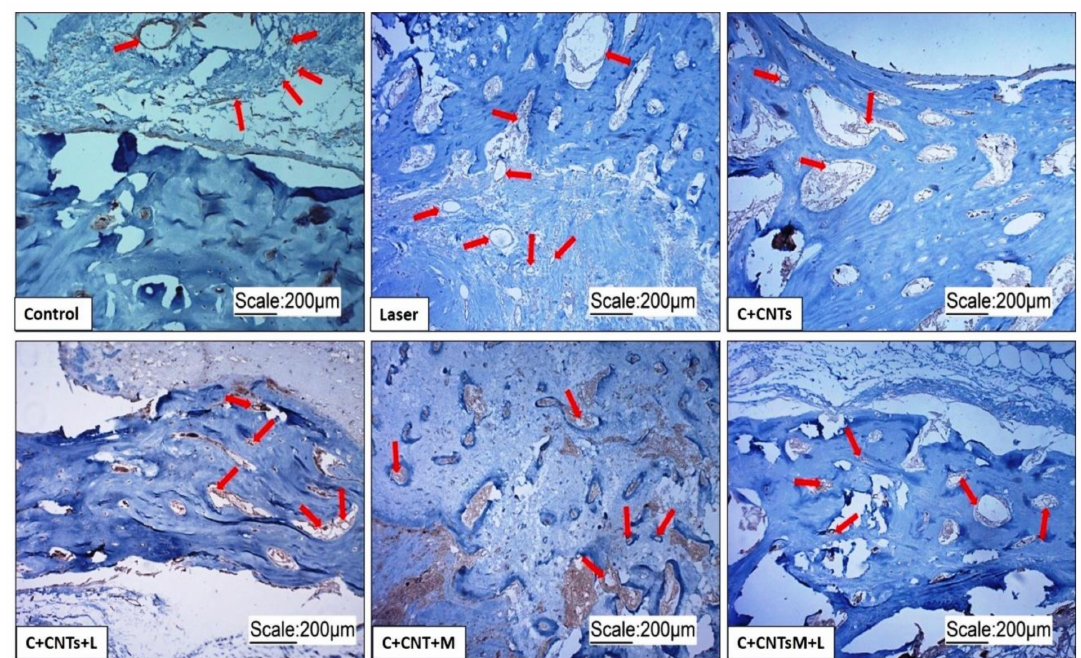
Figure 11. Optical microscope images of VEGF immunostaining of the groups studied. Note the bone defect and the presence of blood vessels (red arrows) distributed along the cortical